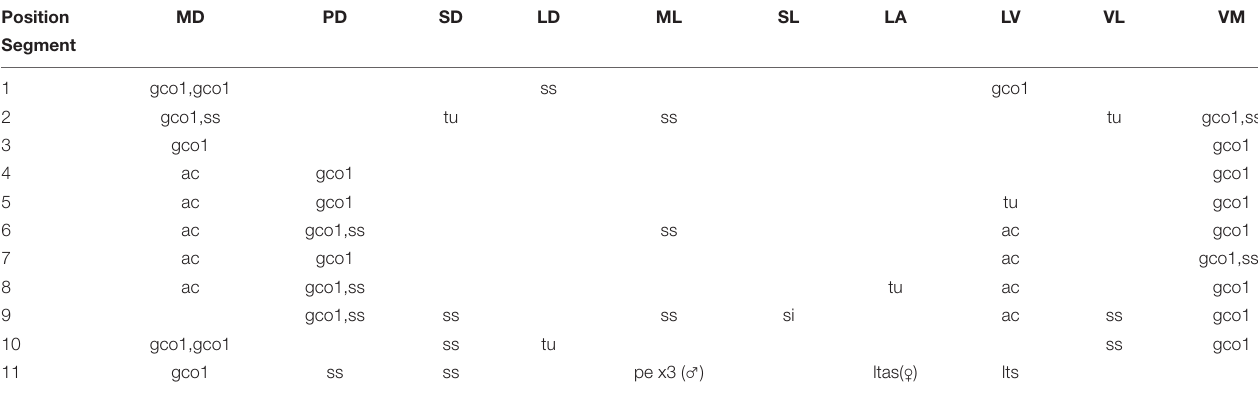
TABLE 3 | Summary of nature and location of sensory spots, glandular cell outlets, tubes and spines arranged by series in Echinoderes mamaqucha sp. nov. Position MD PD SD LD